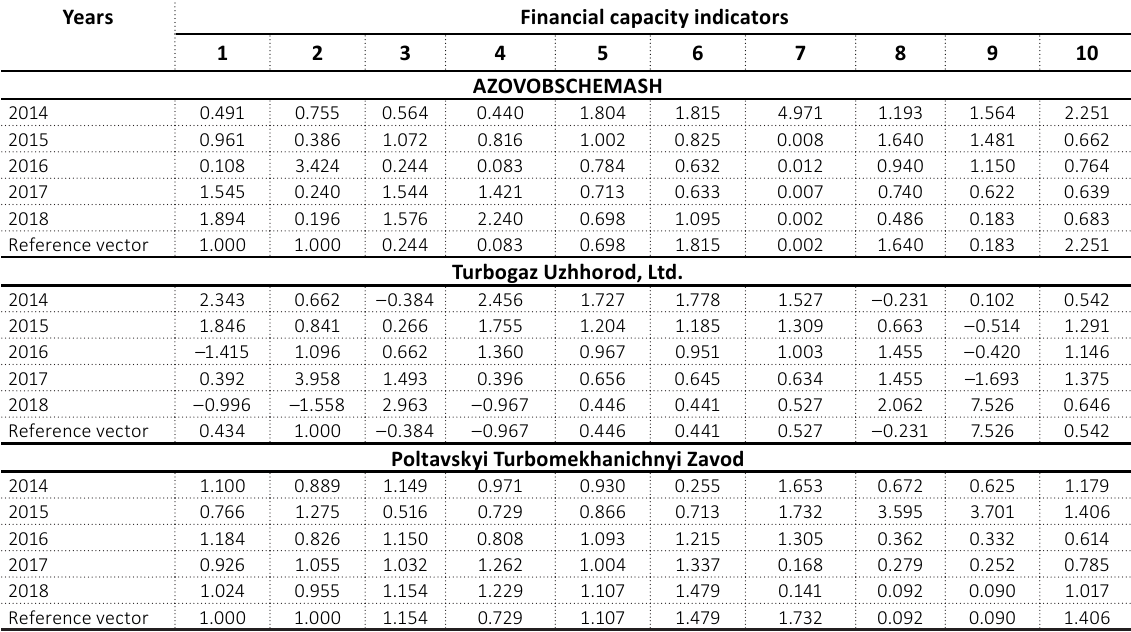
Table A1. Normalized matrix of indicators of enterprises’ financial capacity for